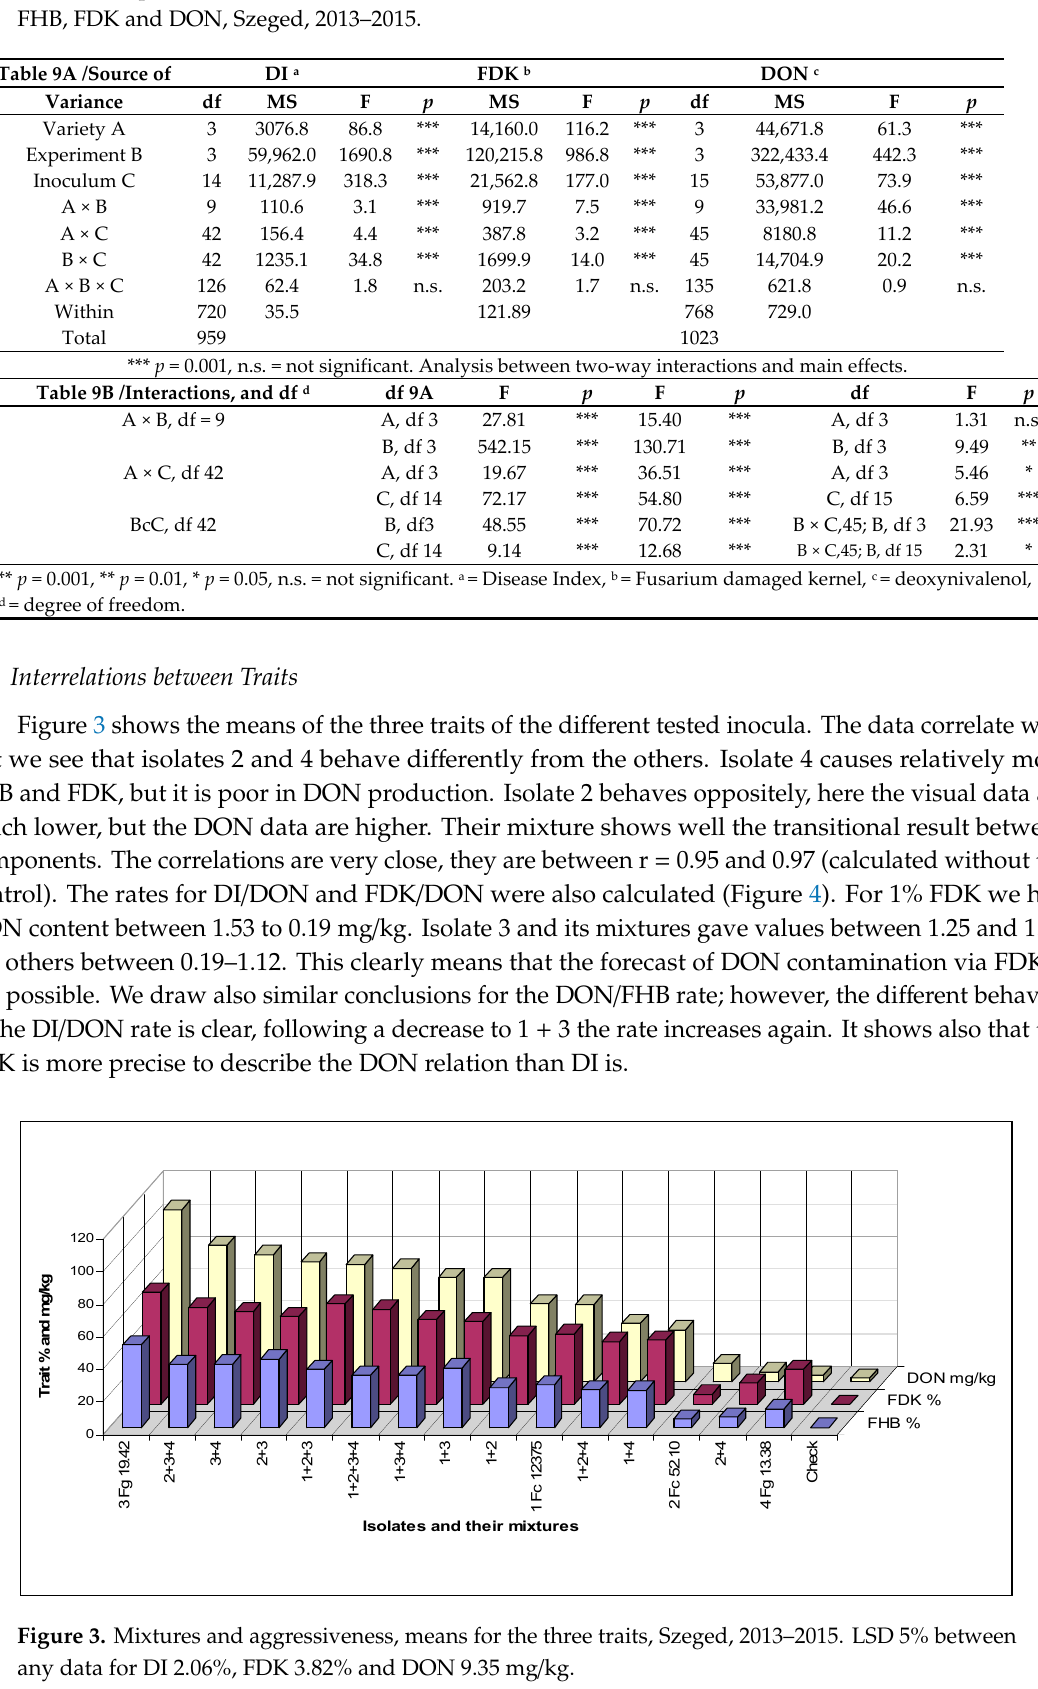
Figure 4. Influence of mixtures on FHB test results. DON production for one percent FHB and FDK infection, 2013–2015. The cultivar reactions as means across inocula and years illustrate the well-known fact that visual head data are less informative for DON than the FDK data are (Figure 5). Based on the FHB values, no DON forecast is possible. GK Csillag is important as this cultivar performed well after a fungicide treatment than any other cultivars tested. Based on data from the milling industry, all staples were bought from this cultivar in 2010 when we had the national FHB epidemic. The correlation between FHB and DON is r = 0.66, which is not highly significant, whereas between FDK and DON the correlation is r = 0.9968, and is significant at p = 0.001. It means that the FDK signalizes the DON content much better than the visual scores.